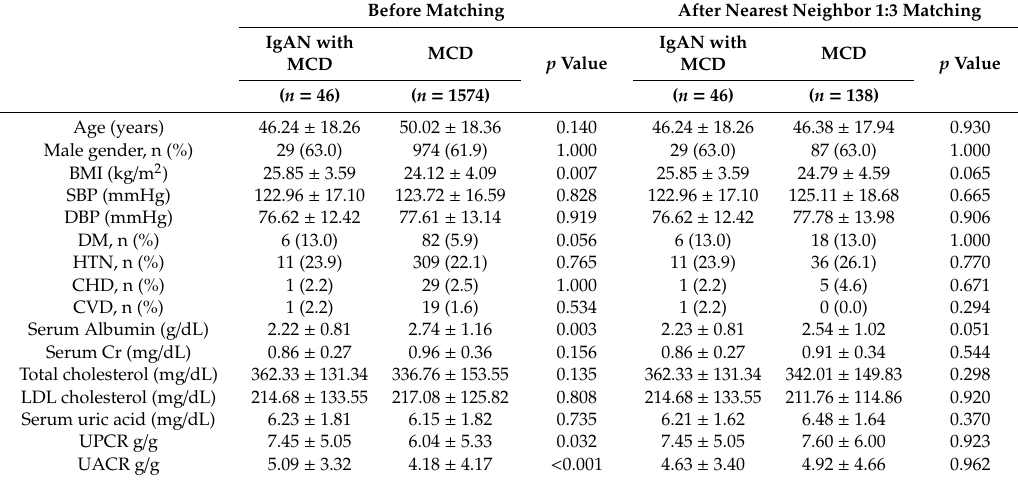
Table 1. Characteristics of the study population at baseline. Before Matching After Nearest Neighbor 1:3 Matching IgAN with IgAN with MCD p MCD p Value MCD MCD